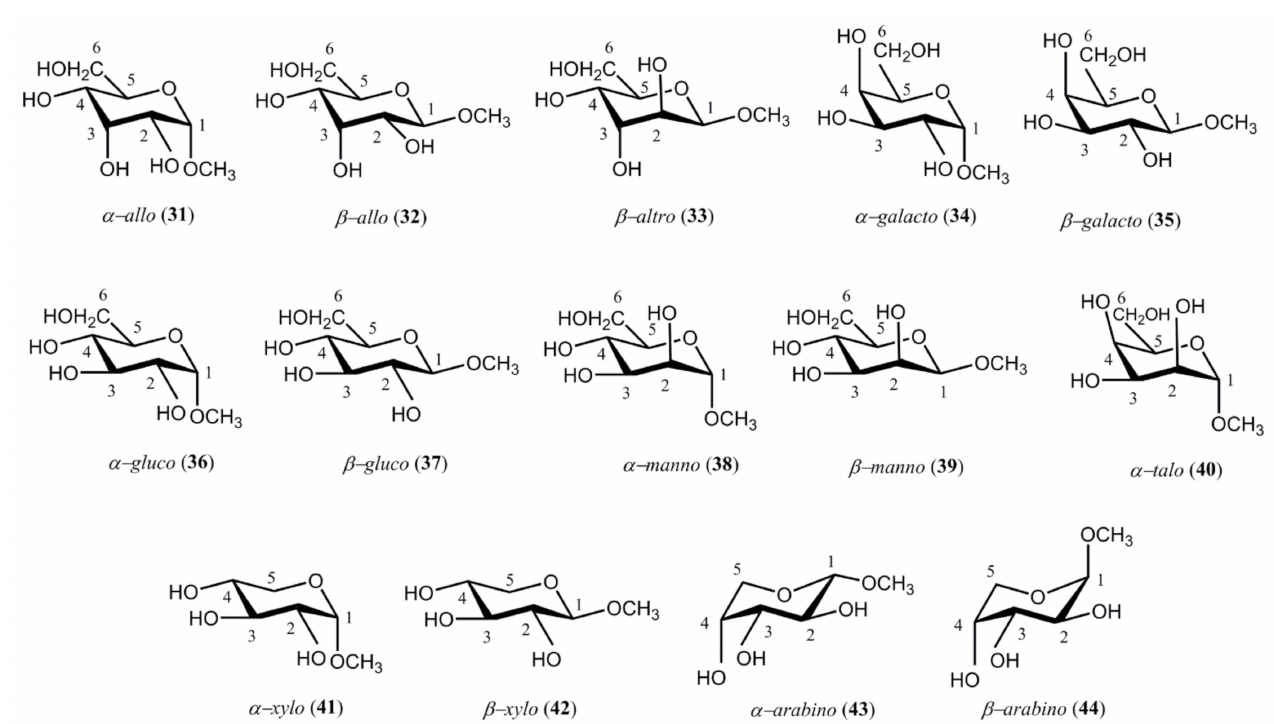
Scheme 4. Representative structures of methyl D-aldopyranosides studied by Podlasek and coworkers